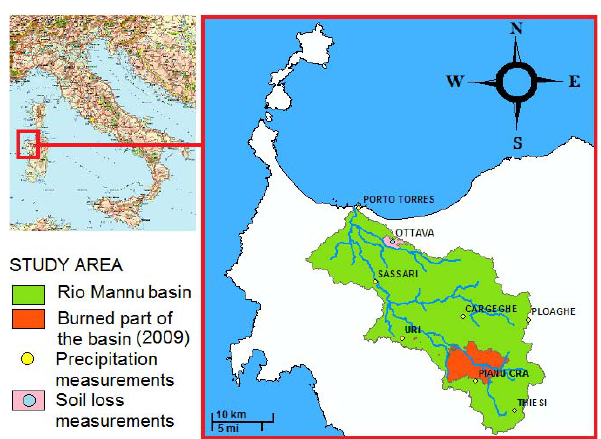
Fig. 1. Rio Mannu watershed, northern Sardinia. The red color rep- resents the burned area following 2009 fire event. The pink area represents field campaigns sites (Porqueddu and Roggero, 1994; Porqueddu et al., 2001). Yellow circles denote rain gauge